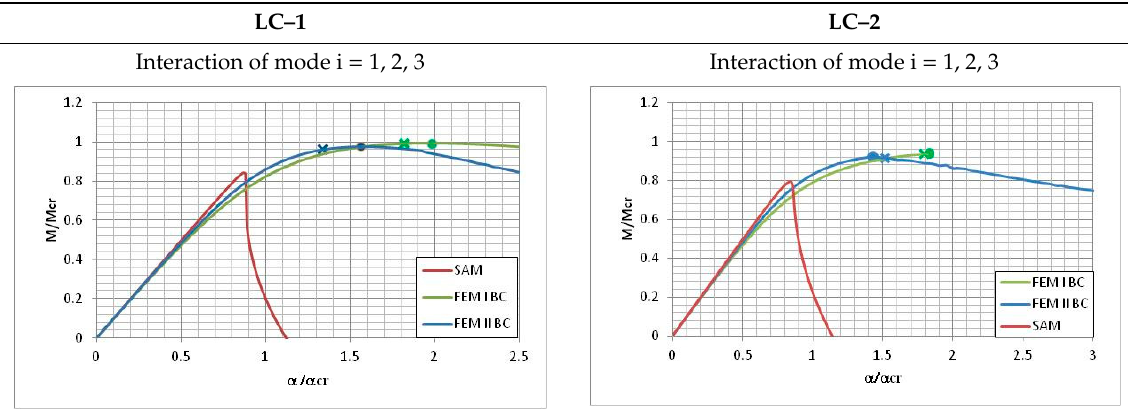
Table 13. Equilibrium paths for interactive buckling of FRP beam.